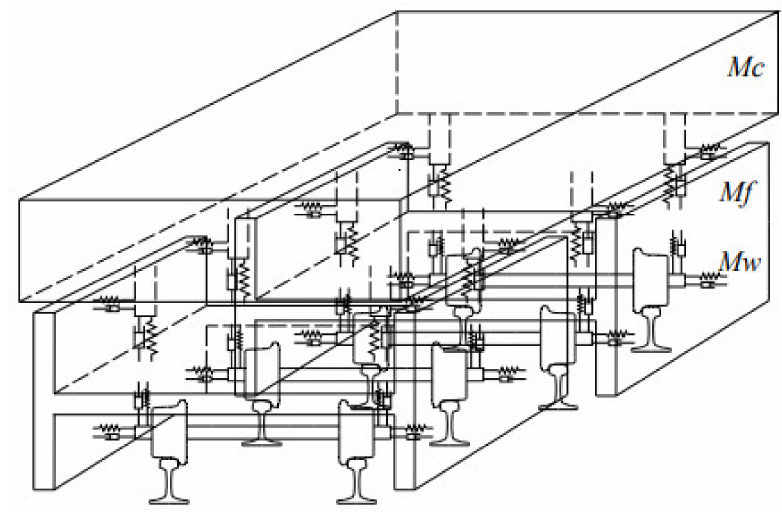
Figure 2. Calculation diagram of four-axle rail vehicle. Table 1. Model DOFs.